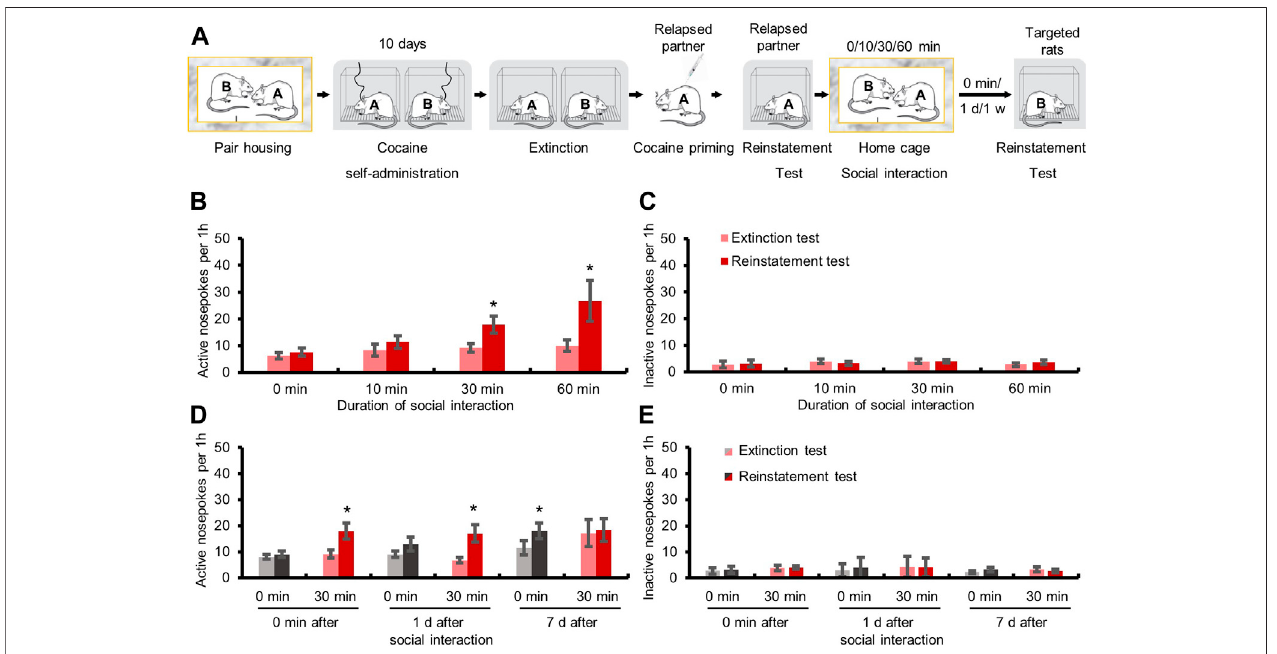
FIGURE 2 | Social interaction with relapsed partners for over 30 min triggered relapse to drug-seeking behavior and this effect lasted for at least 1 day. (A) Experimental timeline. (B) Active nosepokes were enhanced after social interaction with relapsed partner for 30 or 60 min. (C) Inactive nosepokes had no change after social interaction (Data are shown as mean ± SEM. * p < 0.05, compared with extinction test. n (cid:1) 7 – 9). (D) Active nosepokes were increased immediately or 1 day after 30 minsocialinteractionwithrelapsedpartner. (E) Inactivenosepokeshadnochangeaftersocialinteraction(Dataareshownasmean ± SEM.* p < 0.05,compared with extinction test. n (cid:1) 6 –